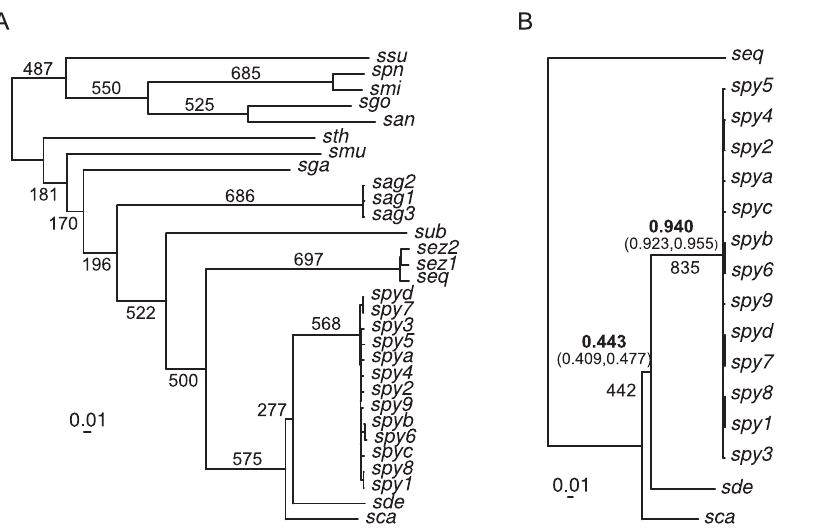
Figure 1. Total evidence trees using the Streptococcus one-to-one core genes (701 orthologs, A) and the four species one-to-one core genes (1072 orthologs, B). On the branches are reported the gene-tree support, as well as the genome wide concordance factors (in bold) with their 95% credibility intervals for the four species analysis. For both trees, total evidence topologies are identical to gene-tree majority rule consensus topologies, as well as the primary concordance topology for the four species tree.